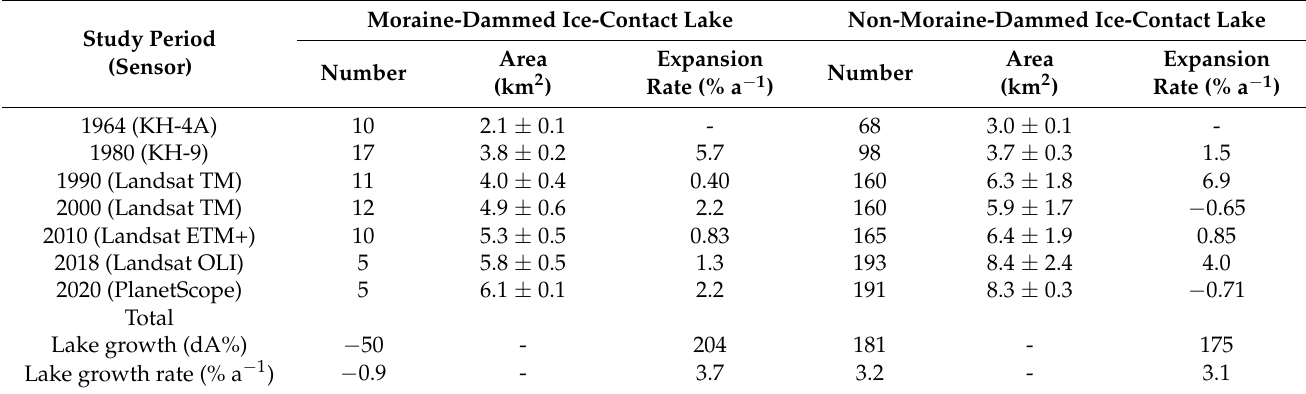
Table 4. The expansion differences between ice-contact lake and non-ice-contact lake in the Tama Koshi basin. Study